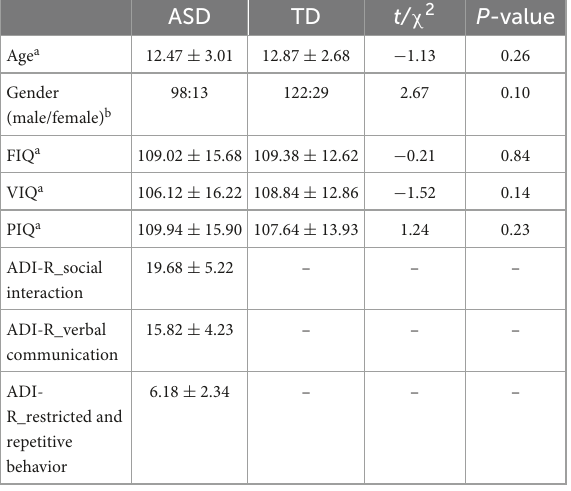
TABLE 2 Comparison between groups of demographic